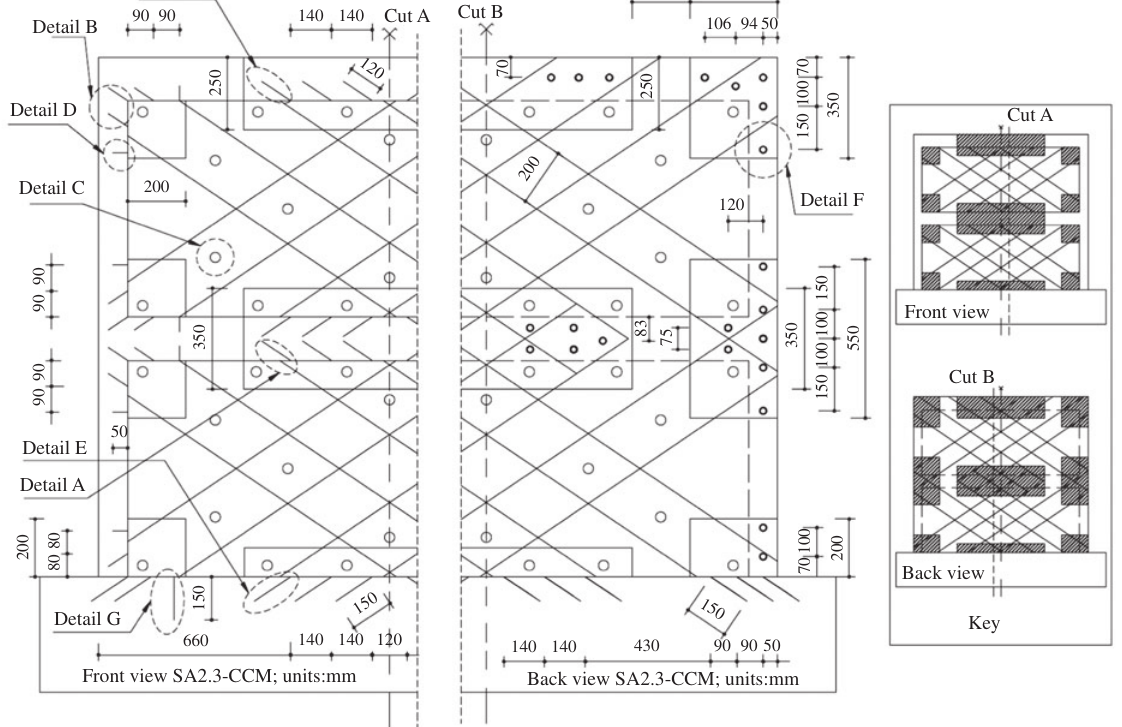
Figure 4 Strengthening details of specimen